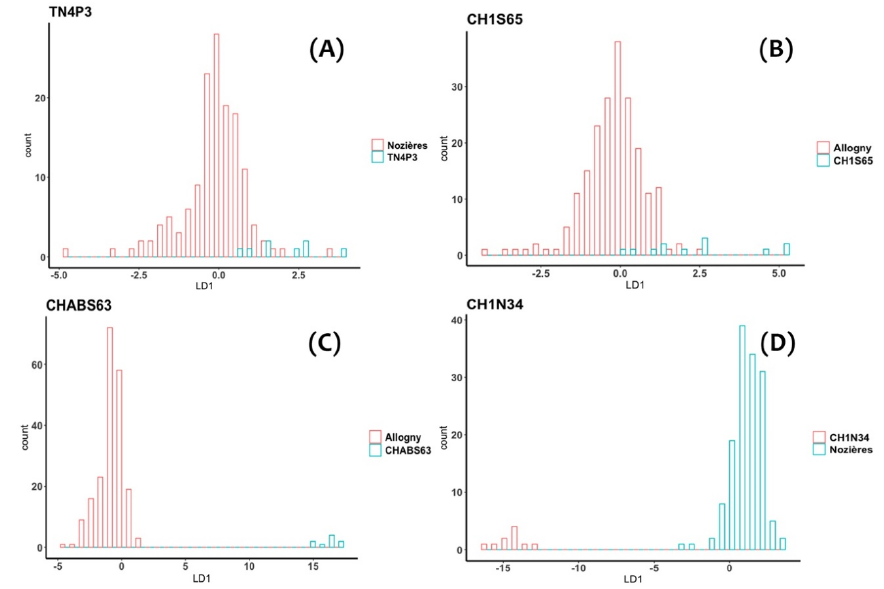
Figure 10. ( A , B ) LDA between an artefact and a production area, examples of compatibility, ( B , C ) LDA between an artefact and a production area, examples of exclusions. Table 4. Results of the LDA analyses comparing one single artefact with a single production area (* indicates recycled samples characterized by metallographic and elemental analyses).